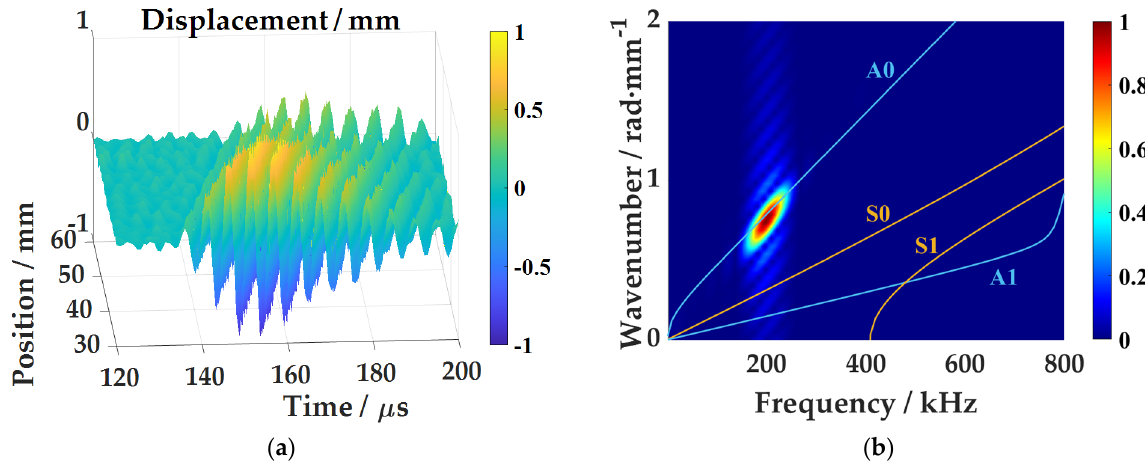
Figure 8. Test results of 2 mm thick CFRP plate: ( a ) Lamb wave one-dimensional time domain wave field; ( b ) Frequency- wavenumber spectrum.